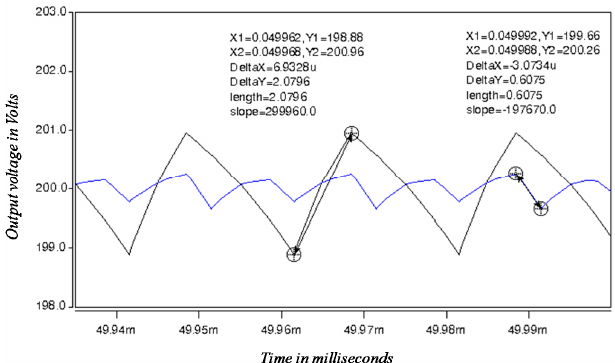
Figure 10. Zoom into the output voltage to measure the switching ripple.